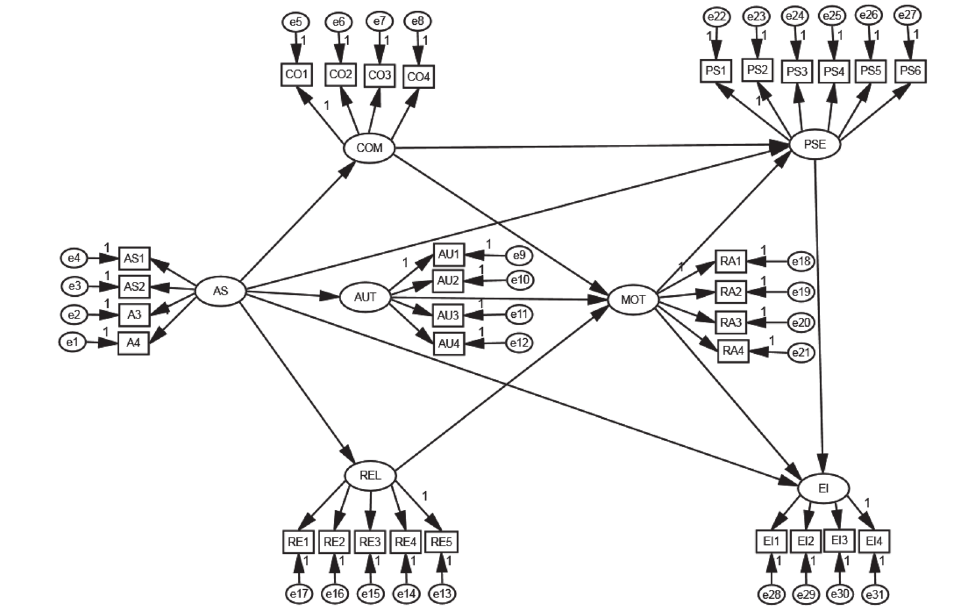
FIGURE 1 Hypothesised structural equation model of the motivational processes to predict physical self-esteem and